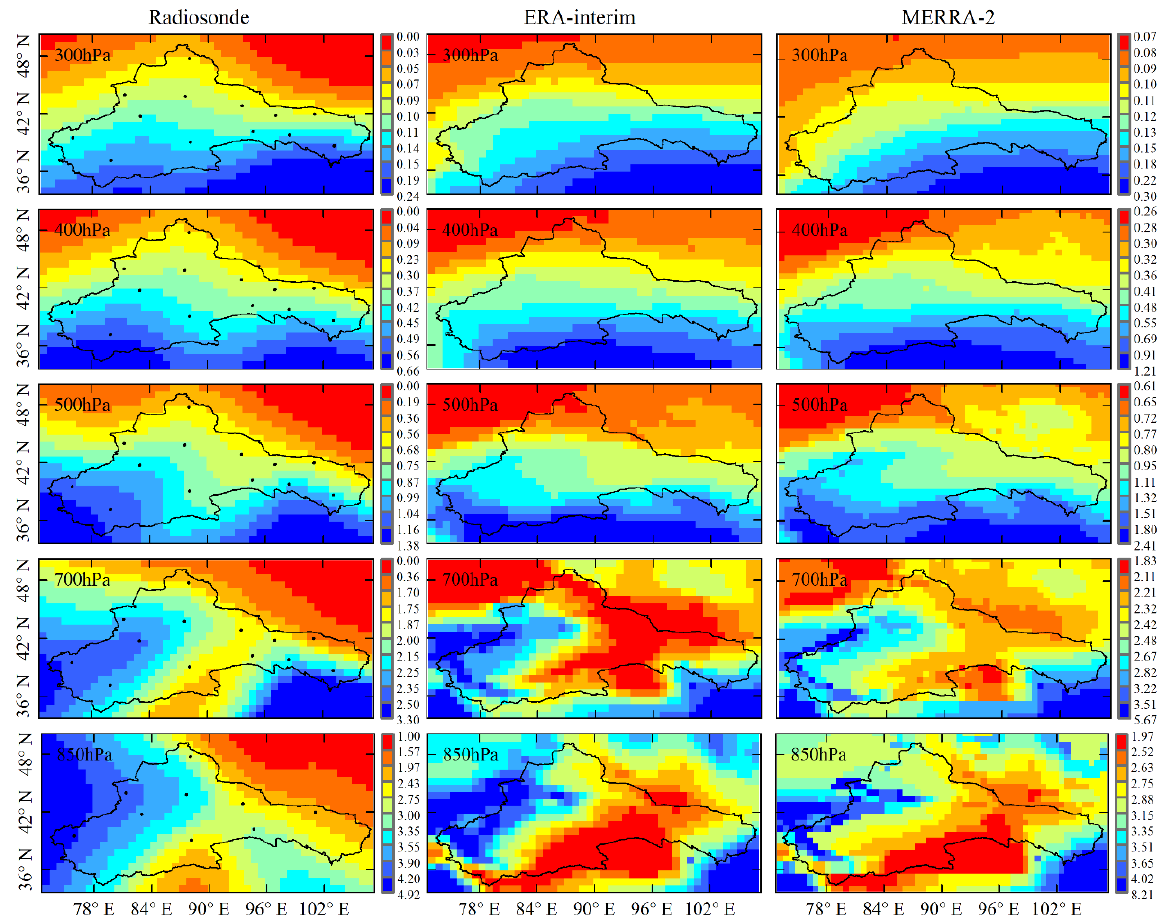
Figure 6. The long-term mean spatial distribution of specific humidity (g/kg) in different atmospheric levels during the period 1980–2018.